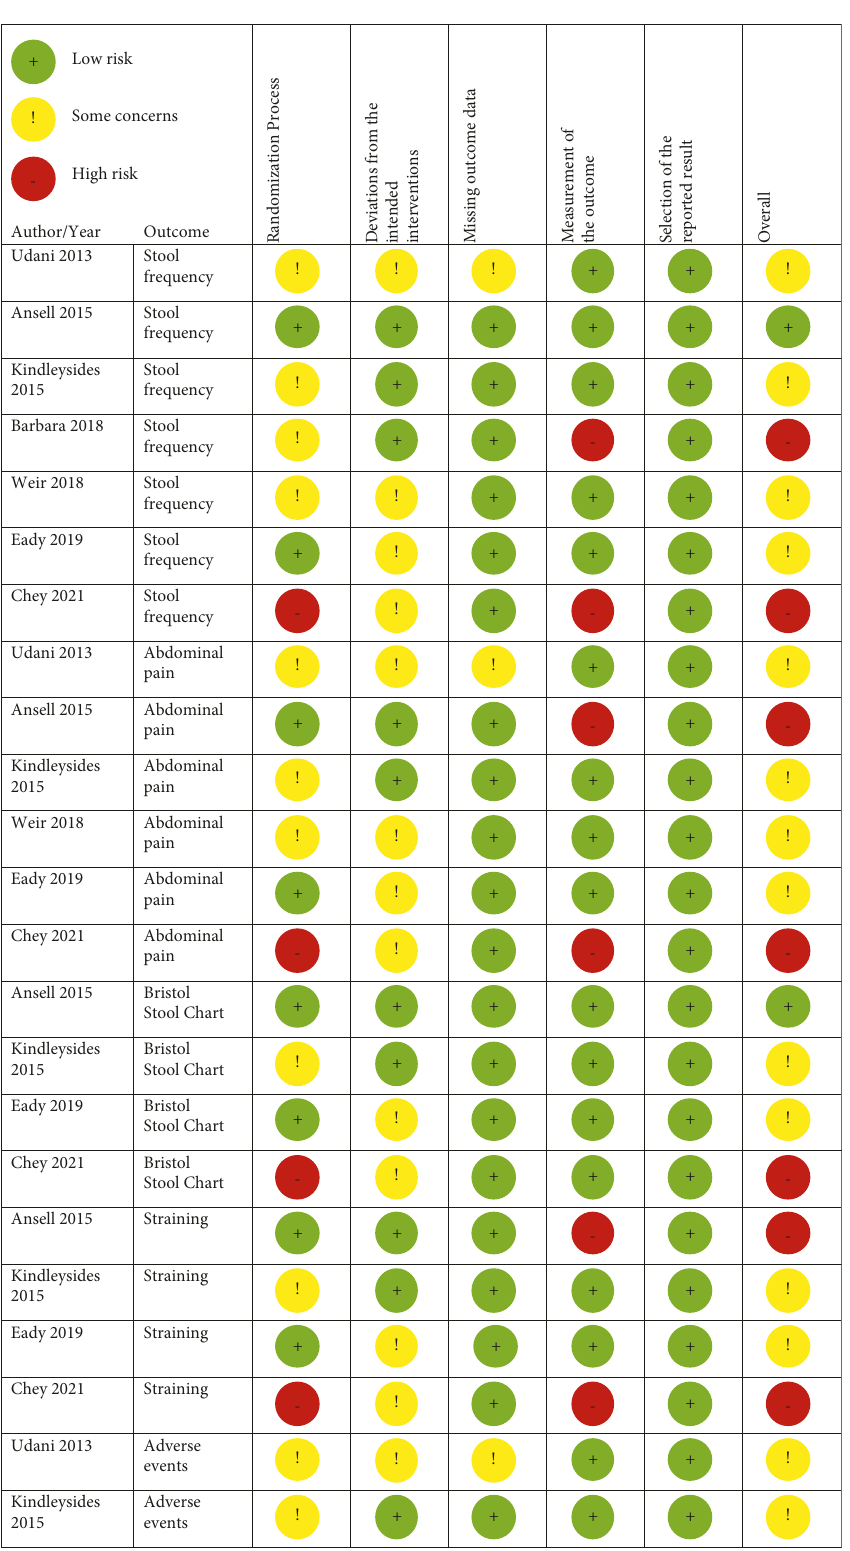
Figure 2: Methodological quality summary by outcome using modified Cochrane Risk of Bias 2.0 3.6. Abdominal Pain. Four studies reported abdominal pain with 186 participants (two parallel and two crossover RCTs). Lower scores indicated clinical improvement. Kiwifruit